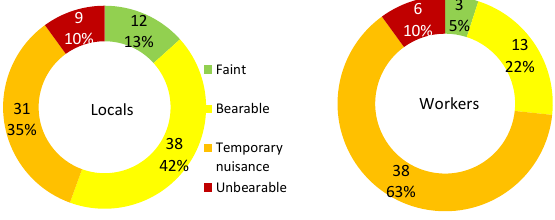
Figure 6: No. of peoples affected by Noise intensity due to project activities w.r.t. locals vs